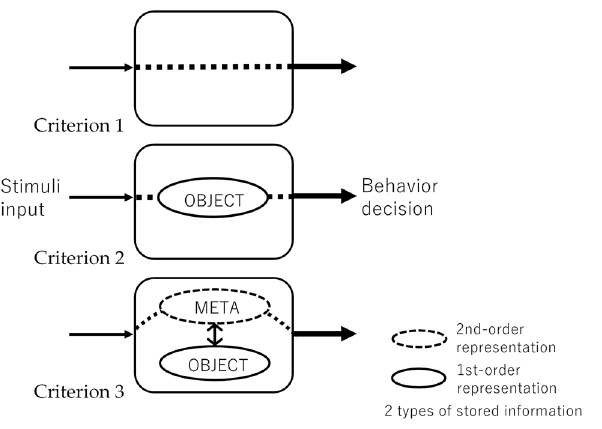
Figure 3. Metamemory